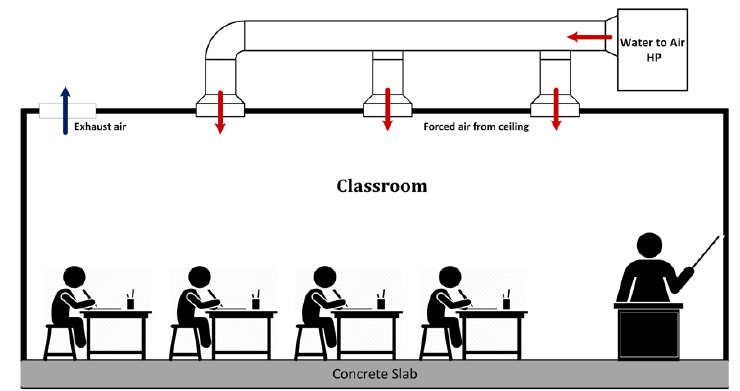
Figure 5. Schematic of a classroom with water–air heat pump.